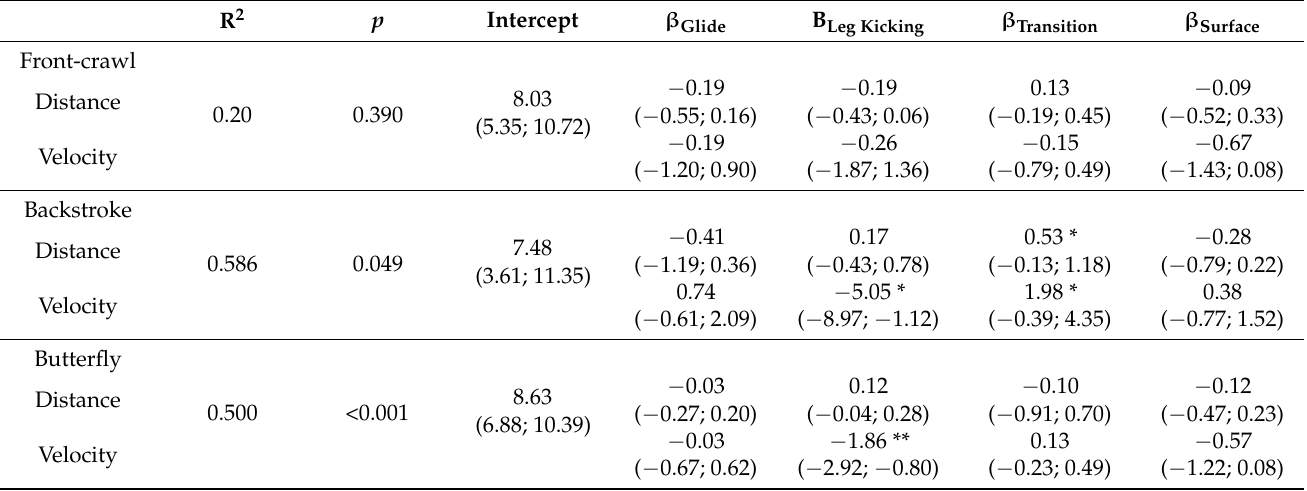
Table 2. The results from the linear multiple regression model with the coefficients and their 95% confidence intervals for each phase of the push start.